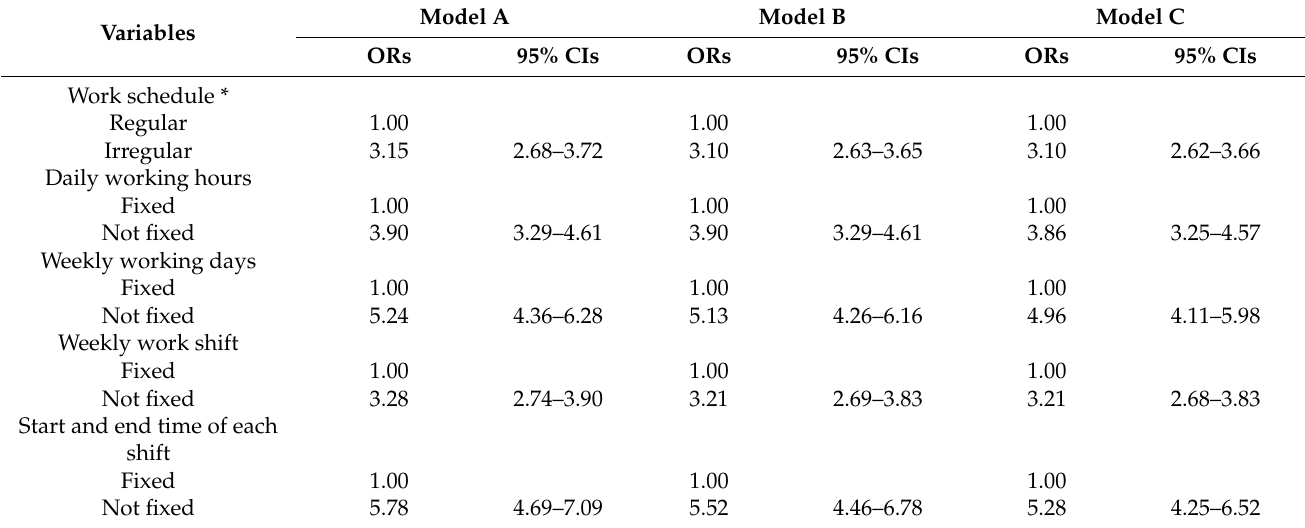
Table 3. Odds ratio and 95% confidence intervals for severe sleep